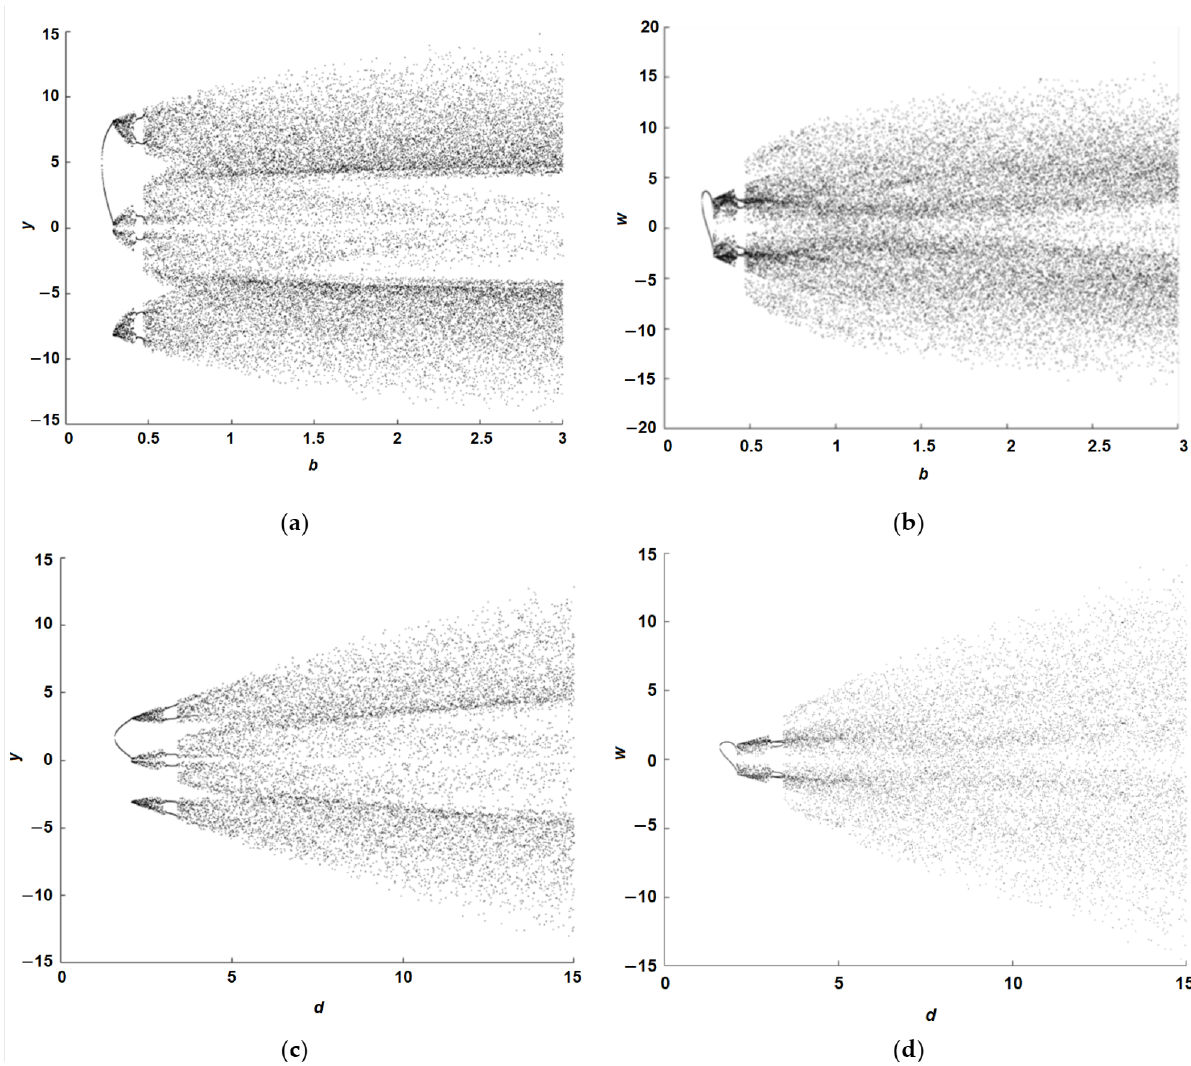
Figure 1. Bifurcation diagrams of parameters b and d : ( a ) b versus y state with variations of b = [0.1–3], ( b ) b versus w state with variations of b = [0.1–3]. ( c ) d versus y state with variations of d = [1.5–15], and ( d ) d versus w state with variations of d =